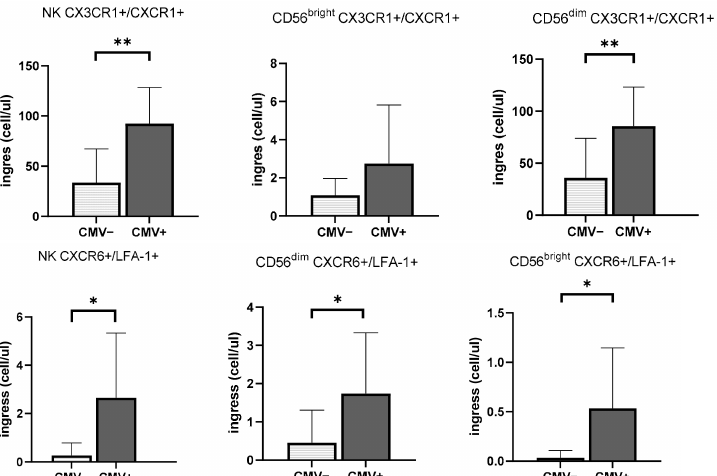
Figure 2. The effect of CMV seropositivity on the mobilization of total NK cells, CD56 dim cells, and CD56 bright cells expressing CX3CR1+/CXCR1+ and CCR6+/LFA-1+ in healthy young adults ( n = 22). Changes in NK cells between resting and post-exercise are represented in light gray for CMV neg participants and in dark gray for CMV pos participants. * Significant differences between CMV pos and CMV neg participants, p < 0.05. ** Significant differences between CMV pos and CMV neg participants, p <